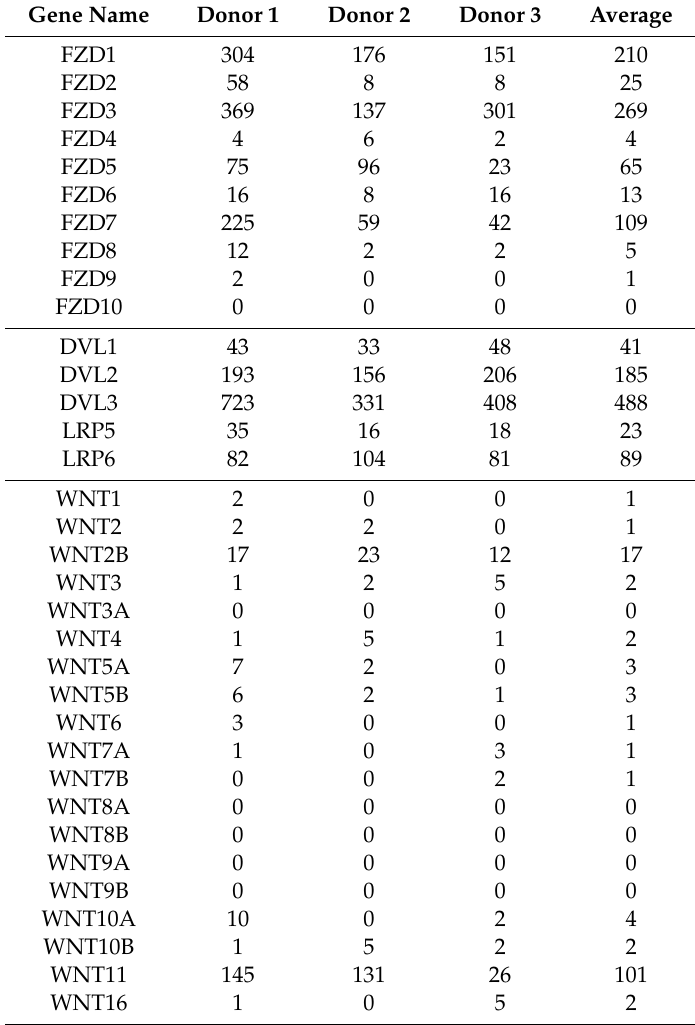
Table 1. mRNA expression of the Wnt signaling system in human lung mast cells. mRNA was extracted from sorted human lung mast cells and RNAseq was performed. DESeq2 normalized counts of FZDs, DVL1-3, LRP5 / 6, and all 19 WNTs are